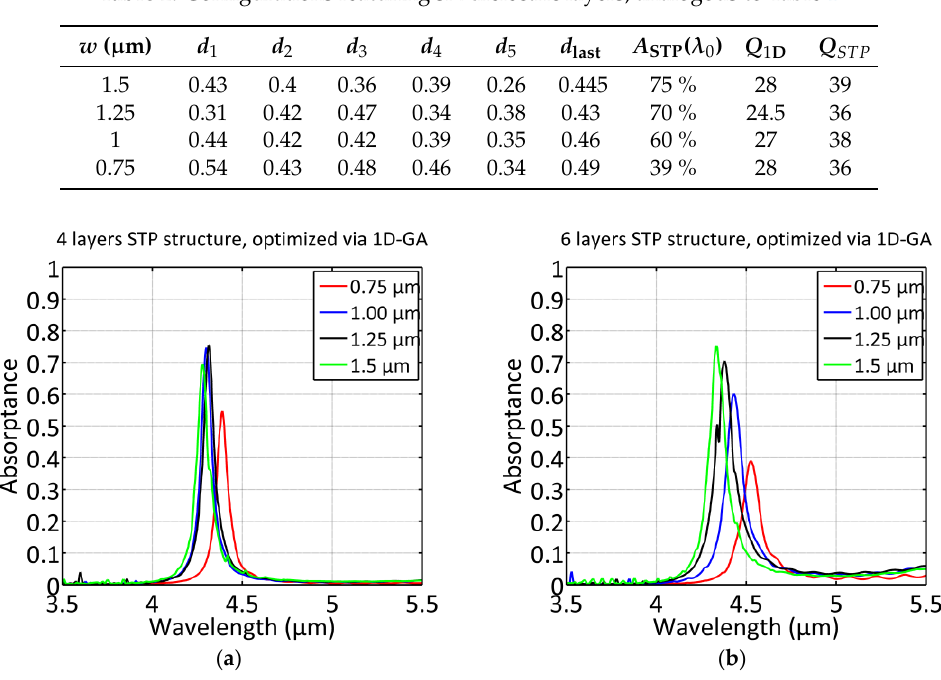
Figure 3. Spectral response of the STP structures (TE) for four ( a ) and six layers ( b ), respectively. The thicknesses were obtained by the GA optimization process featuring purely 1D TP structures.